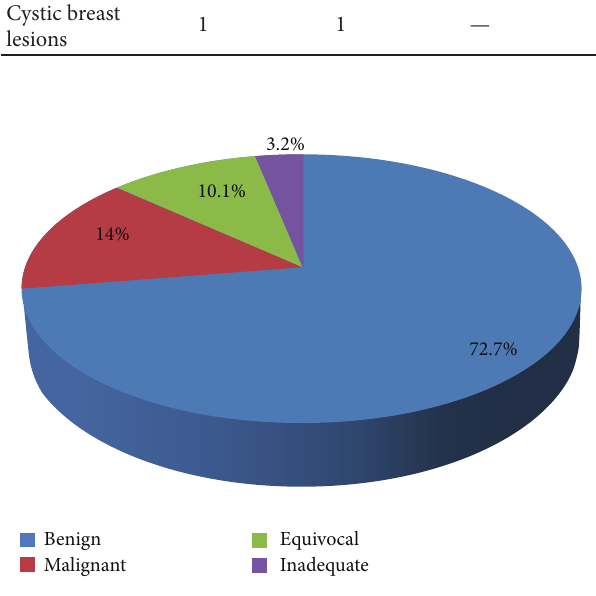
Figure 2: Spectrum of cytologic diagnosis.